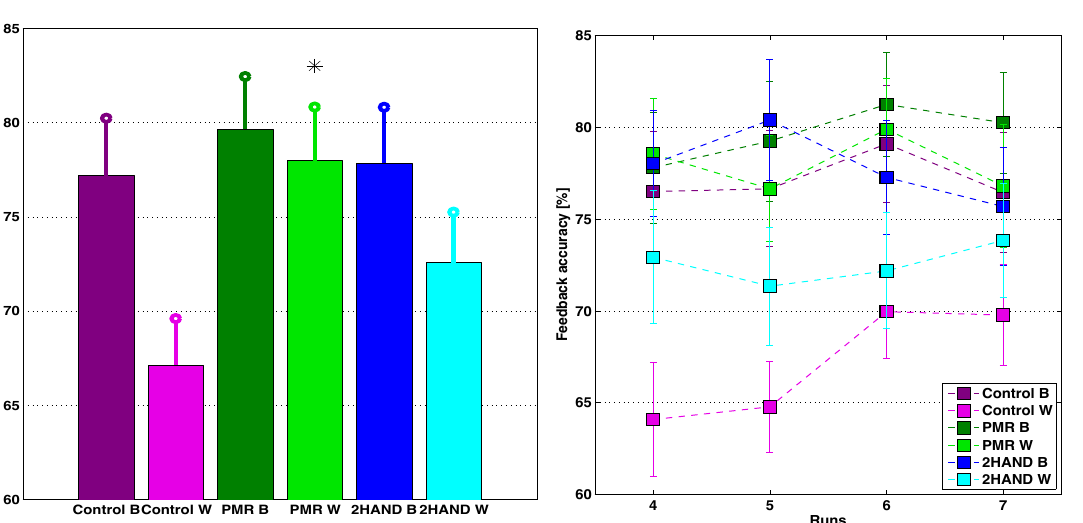
Fig 3. Mean BCI feedback accuracies for each intervention group (Control, PMR, 2HAND) over runs 4 – 7 (left) and run-wise (right). ‘ B ’ refers to participants of Berlin and ‘ W ’ to participants of Würzburg. PMR W has significantly higher mean BCI performance compared to Control W (p < 0.05), marked with a star in the bar